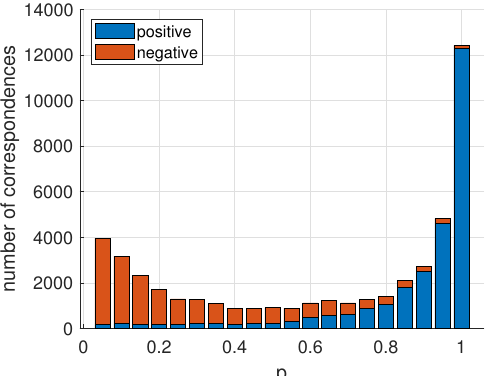
Figure 4. The probability distribution for both correct (blue) and wrong (red) correspondences in grand_place_brussels from